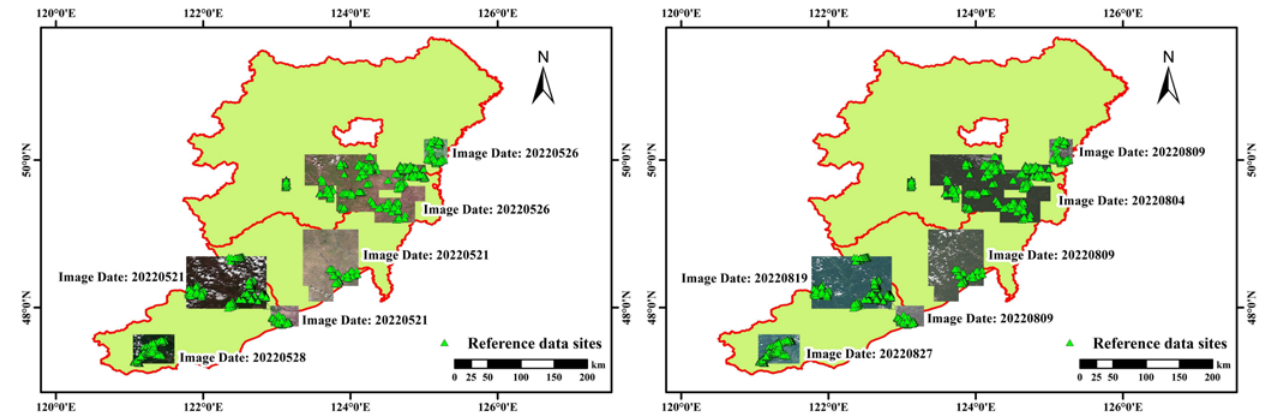
Figure 2. Distribution of reference data sites. Sowing period image data (left); vigorous period image data (right).